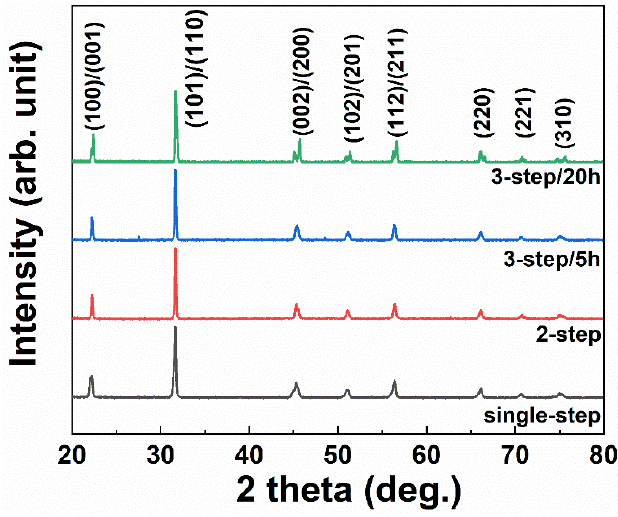
Figure 1. XRD patterns of 0.92KNLN-0.08BZ ceramics prepared using single-step, 2-step, 3-step/5 h and 3-step/20 h sintering processes.